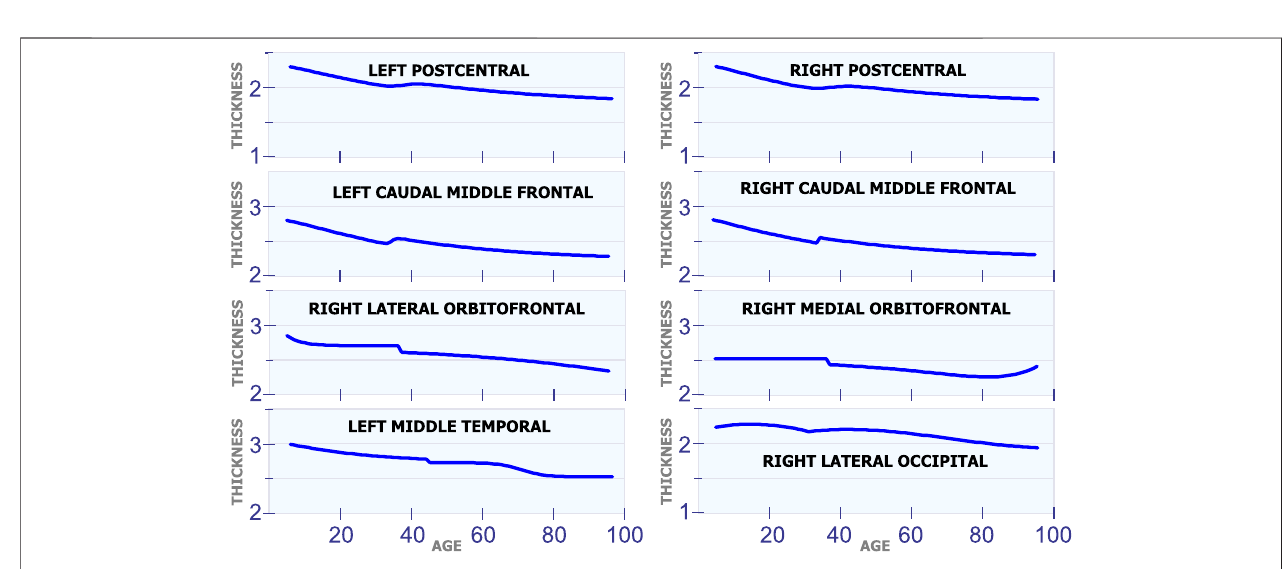
FIGURE 3 | Regions with changes in cortical thickness around 40 years of